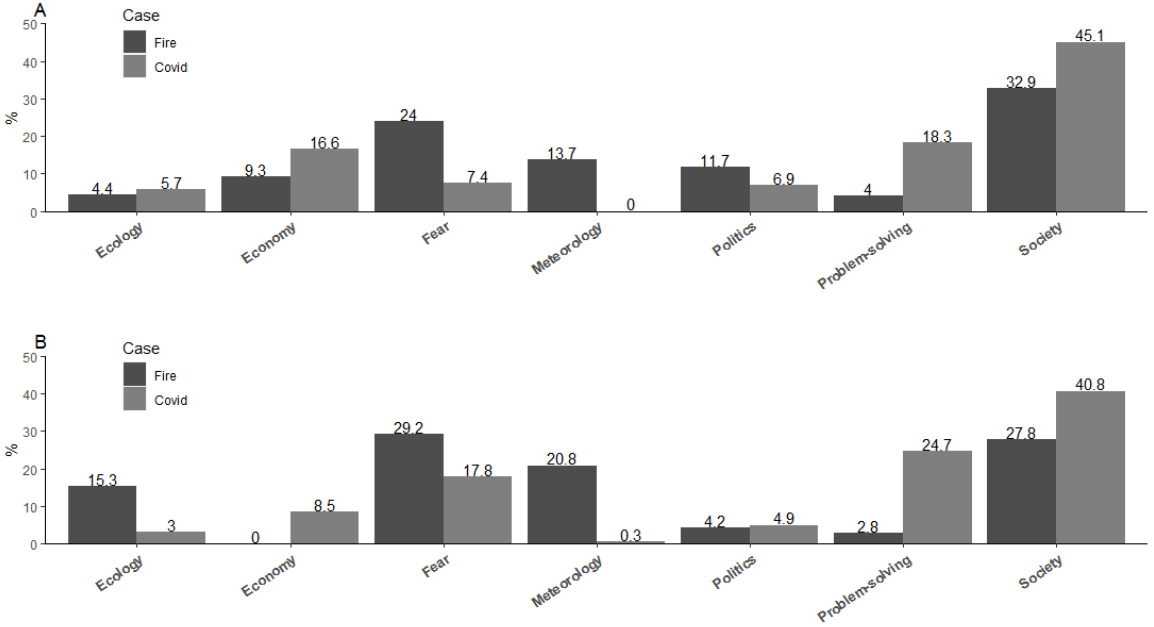
Figure 2. Thematic frames of the articles, The New Daily ( A ) and Index ( B ).